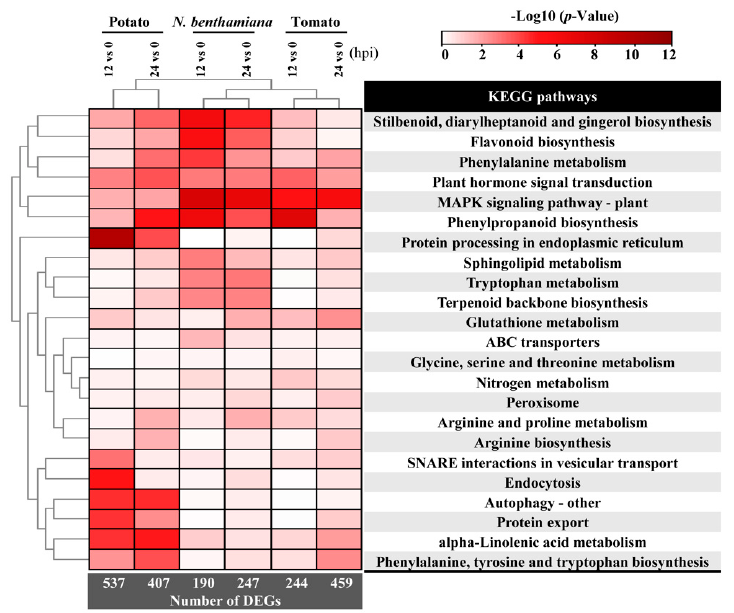
Figure 5. Hierarchical clustering analysis of KEGG pathways comparison demonstrated the differential response among TSHs induced by P. infestans . DEGs related to significant enrichment analysis were involved in different processes, represented by squares with different colors. The color scale showed the values ( p -value). In particular, S. tuberosum activated many more pathways, including “protein pro-